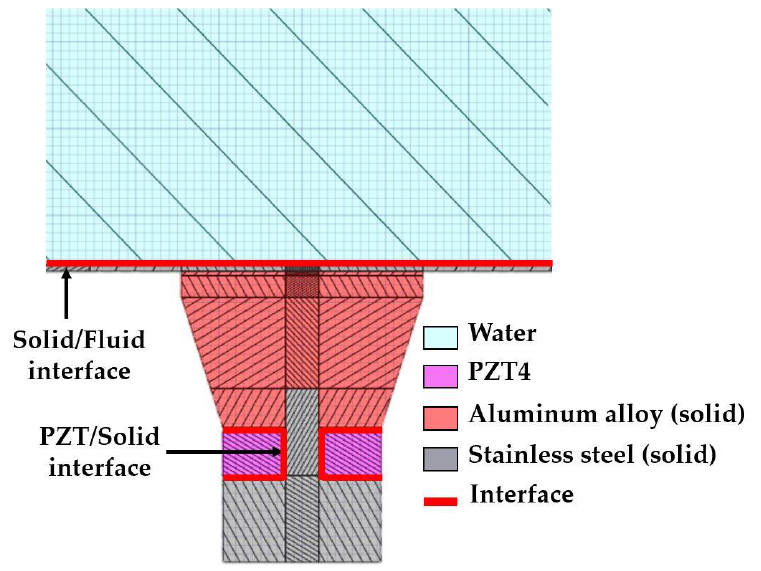
Figure 1. Material domains and interfaces.